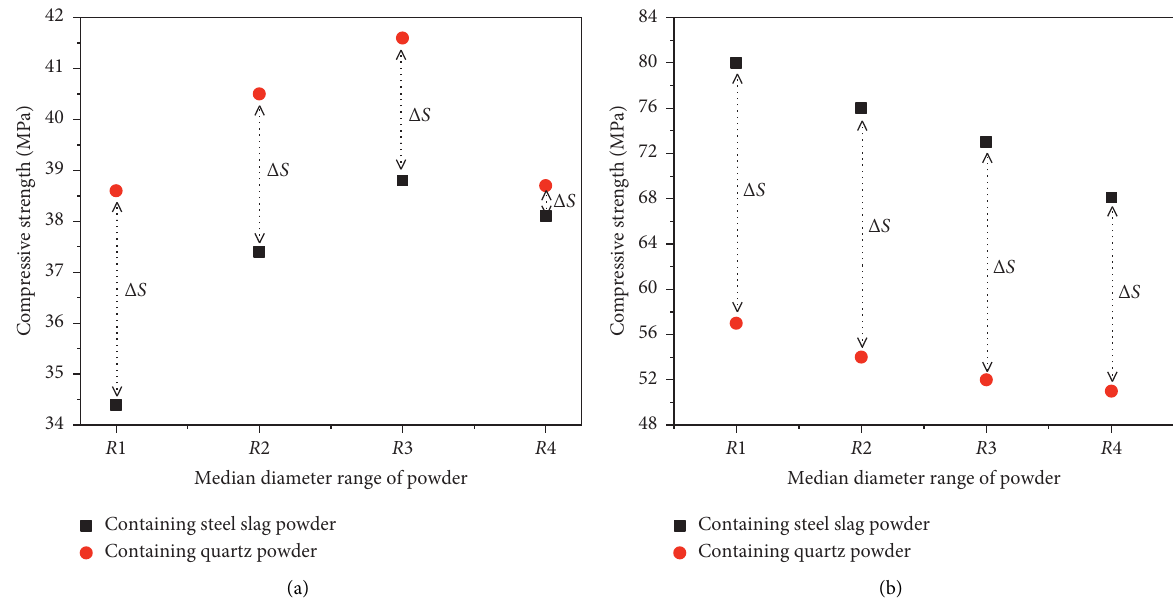
Figure 14: Compressive strength blended cement paste containing different particle size steel slag and quartz powder. (a) 3d. (b) 28d.